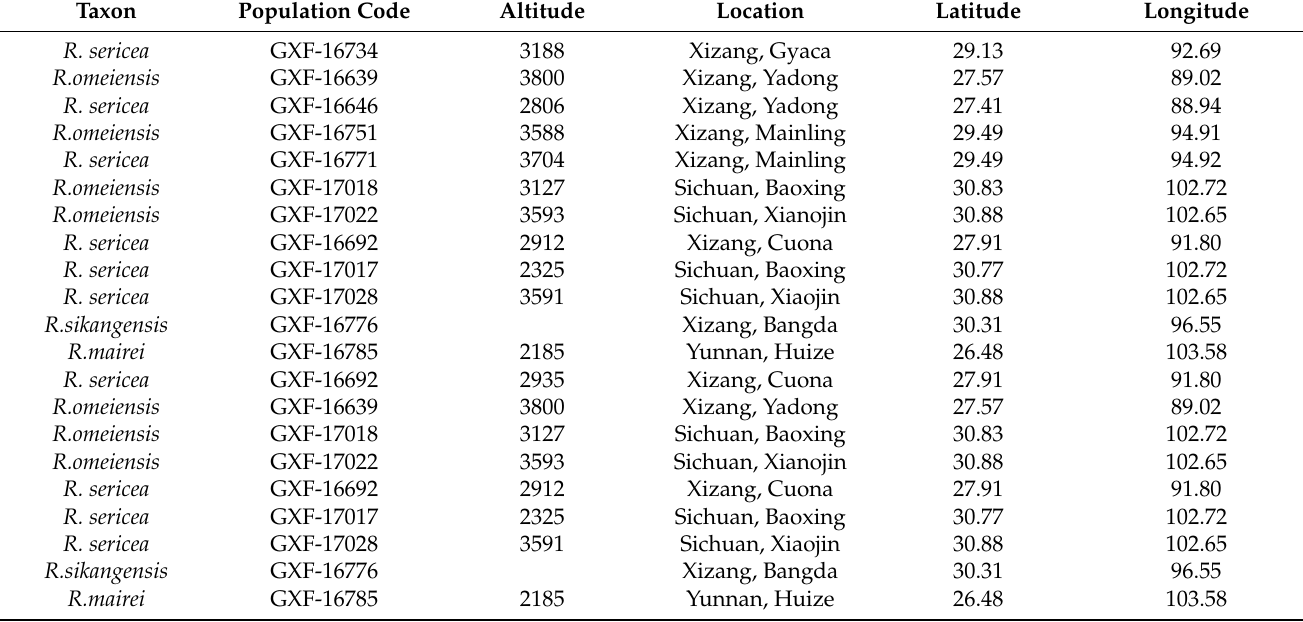
Figure 1. Distribution of species of the R. sericea complex. Table 1. Collection of information on different populations of Rosa sericea complex specimens. Taxon